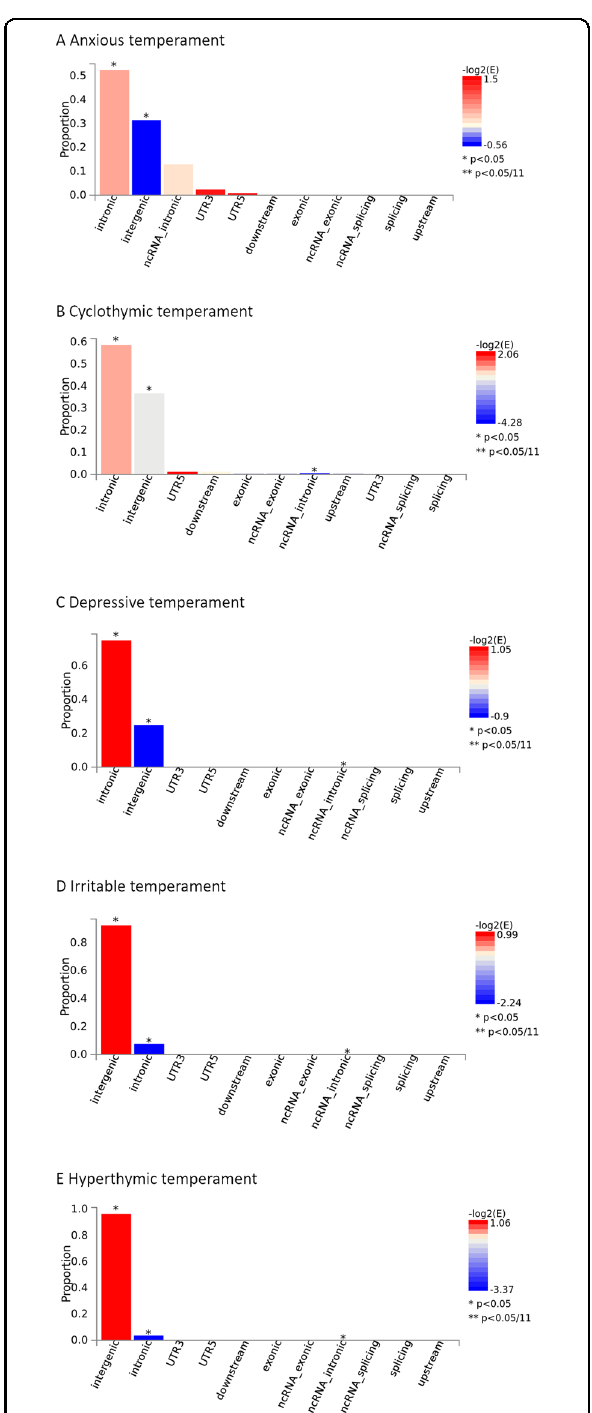
Fig. 3 Genomic location and functional consequences of SNPs for affective temperament phenotypes. Histogram of functional consequences of SNPs for anxious ( A ), cyclothymic ( B ), depressive ( C ), irritable ( D ), and hyperthymic ( E )